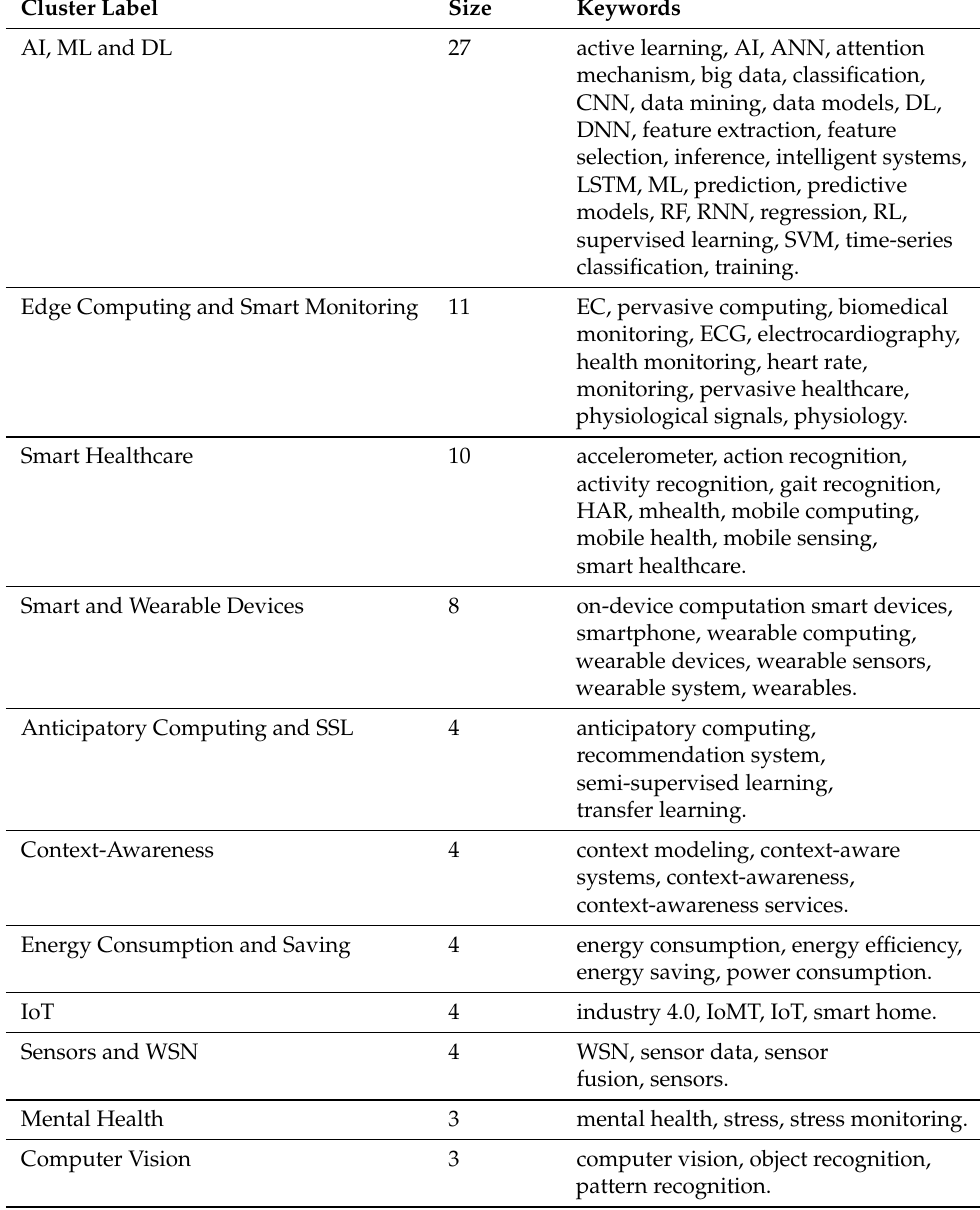
Table 4. The identified eleven clusters of keywords along with the titles of the subjects (cluster labels) they represent. Cluster Label